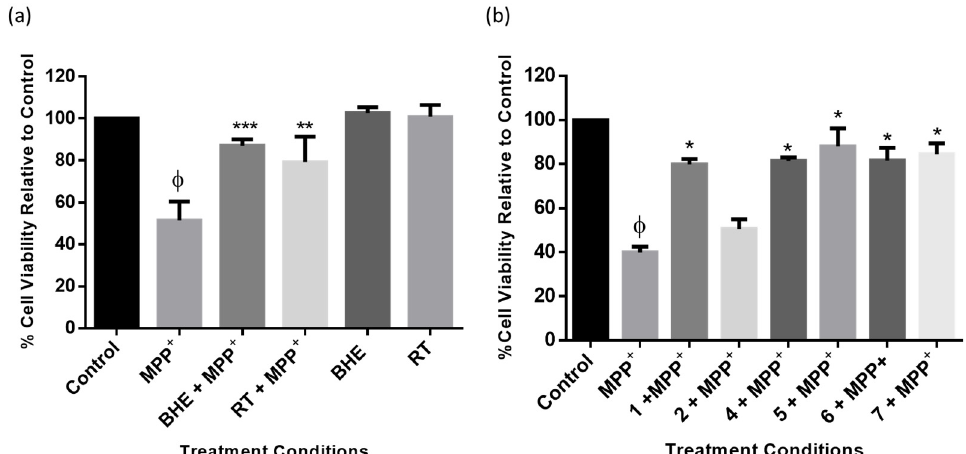
Figure 6. BHE and compounds show protection in SH-SY5Y cells. Cells were pre-treated with extracts ( a ) and compounds ( b ) before exposure to MPP + for 24 h. Each bar represents mean percentage cell viability relative to control, and significance of difference indicated with * ( p < 0.05), ** ( p < 0.01), and *** ( p < 0.001) when extract/compounds are compared to MPP + and ϕ (MPP + vs. control).